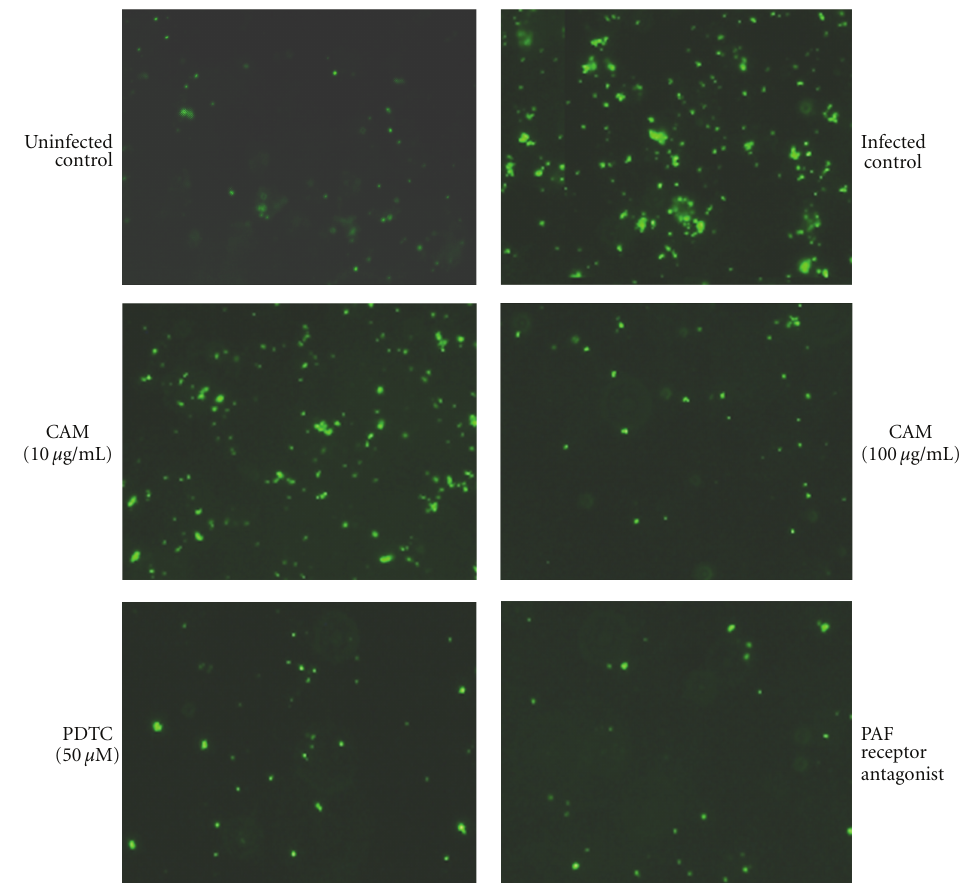
Figure 4: Suppression by CAM of RSV-induced adhesion of FITC-labeled S. pneumoniae to A549 cells, as observed by fluorescence microscopy. One hour before RSV infection, CAM (10 or 100 μ g/mL) or PDTC (50 μ M) was added to A549 cell monolayer. The cells were infected with RSV at MOI of 1. After 24h of infection, FITC-labeled bacterial cells were added to the cell monolayer at MOI of 10, and incubation was continued at 37 ◦ C for 30 min. A PAF receptor antagonist (20 μ g/mL) was added to the cell monolayer 1 h before the addition of labeled bacterial cells. The bacteria adhering to the A549 cell monolayer were visualized by fluorescence microscopy.